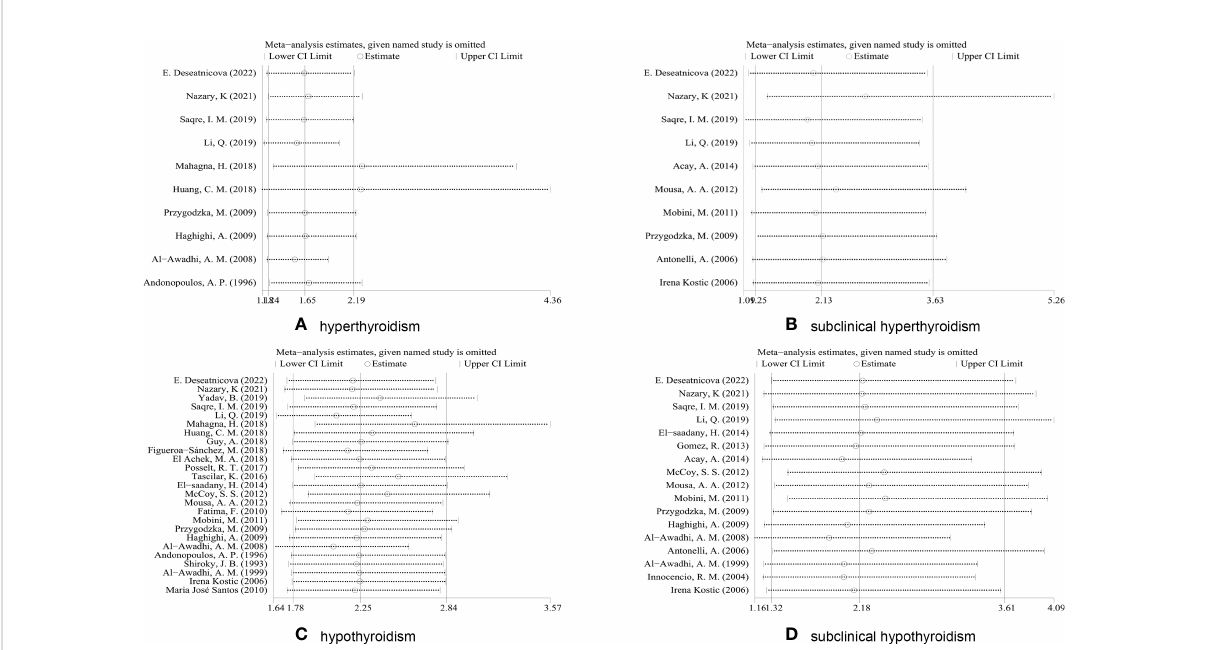
FIGURE 3 Sensitivity analysis based on excluding each study in turn. (A) Sensitivity analyses for the association of RA and hyperthyroidism. (B) Sensitivity analyses for the association of RA and subclinical hyperthyroidism. (C) Sensitivity analyses for the association of RA and hypothyroidism. (D) Sensitivity analyses for the association of RA and subclinical